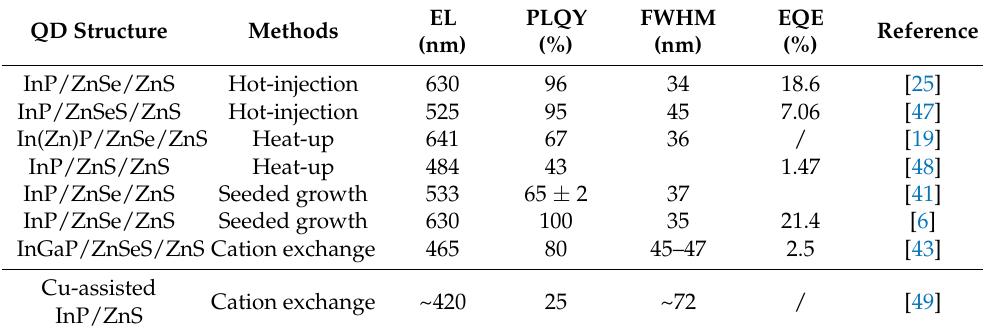
Table 2. Representative synthesis methods of InP QDs and EQE of